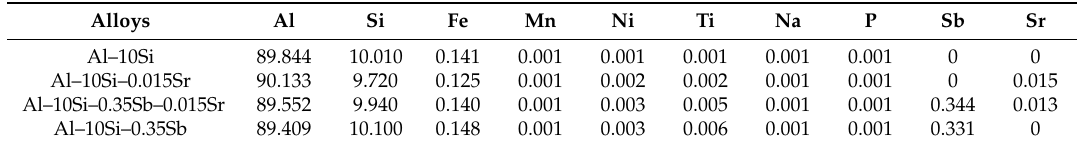
Table 1. Chemical composition of samples (wt.